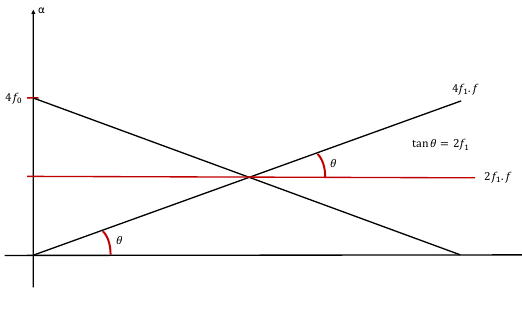
Figure 9. The theoretical relations between “ α ” and “ f ” for the model (9) when U ( t ) is stationary.